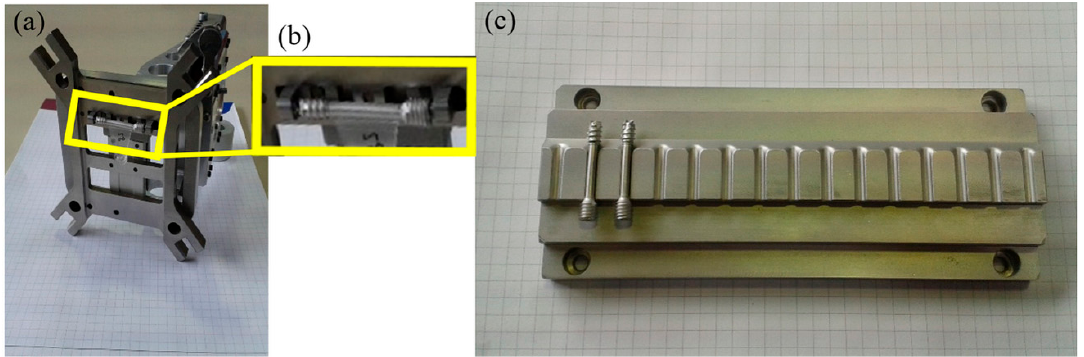
Figure 12. Equipment for the automation process ( a ) and ( b ) automation gripper and ( c ) tray unit.